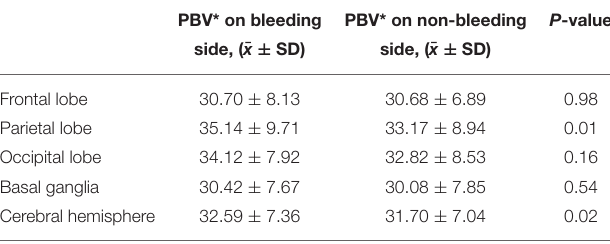
TABLE 1 | Demographics and clinical features of patients with aSAH. Characteristics